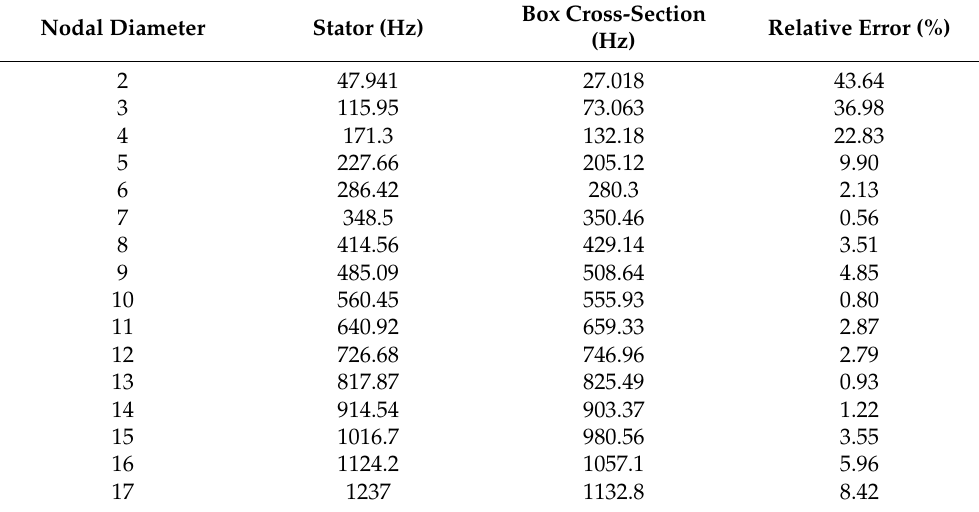
Figure 13. Full circle of physical replacement with box cross-section. Table 7. Mode frequency of flexural motion.